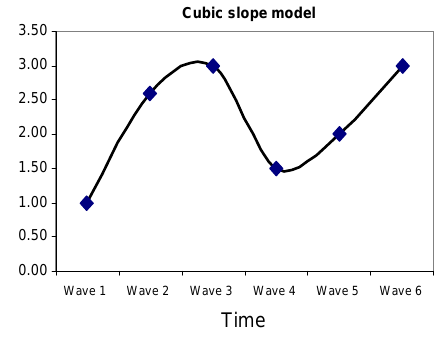
FIGURE 3 . A hypothesized cubic slope